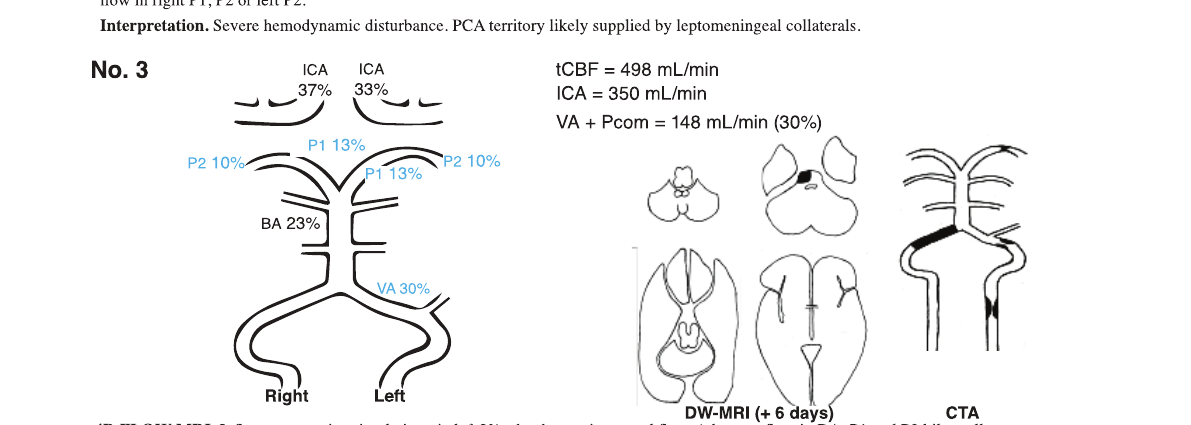
Frontiers in Neuroscience |